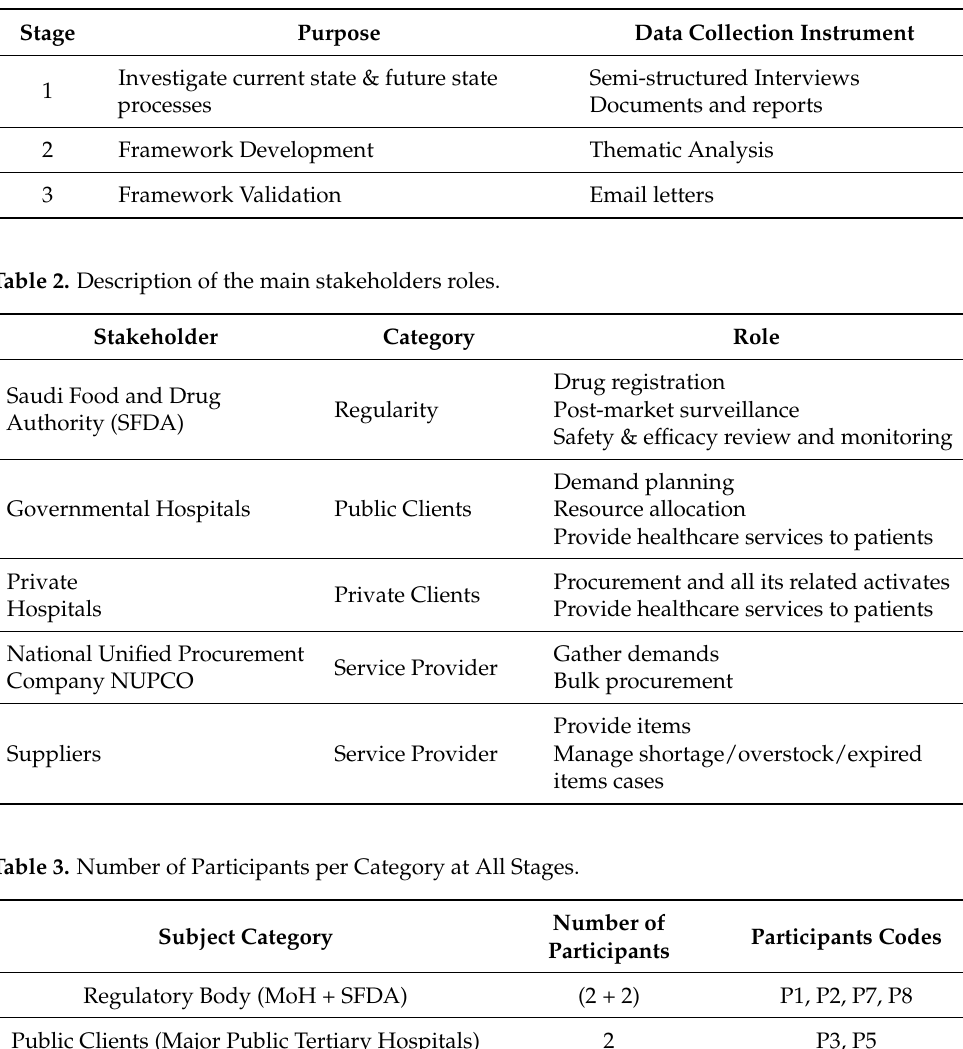
Table 1. Summary of data sources through system design of the proposed framework.